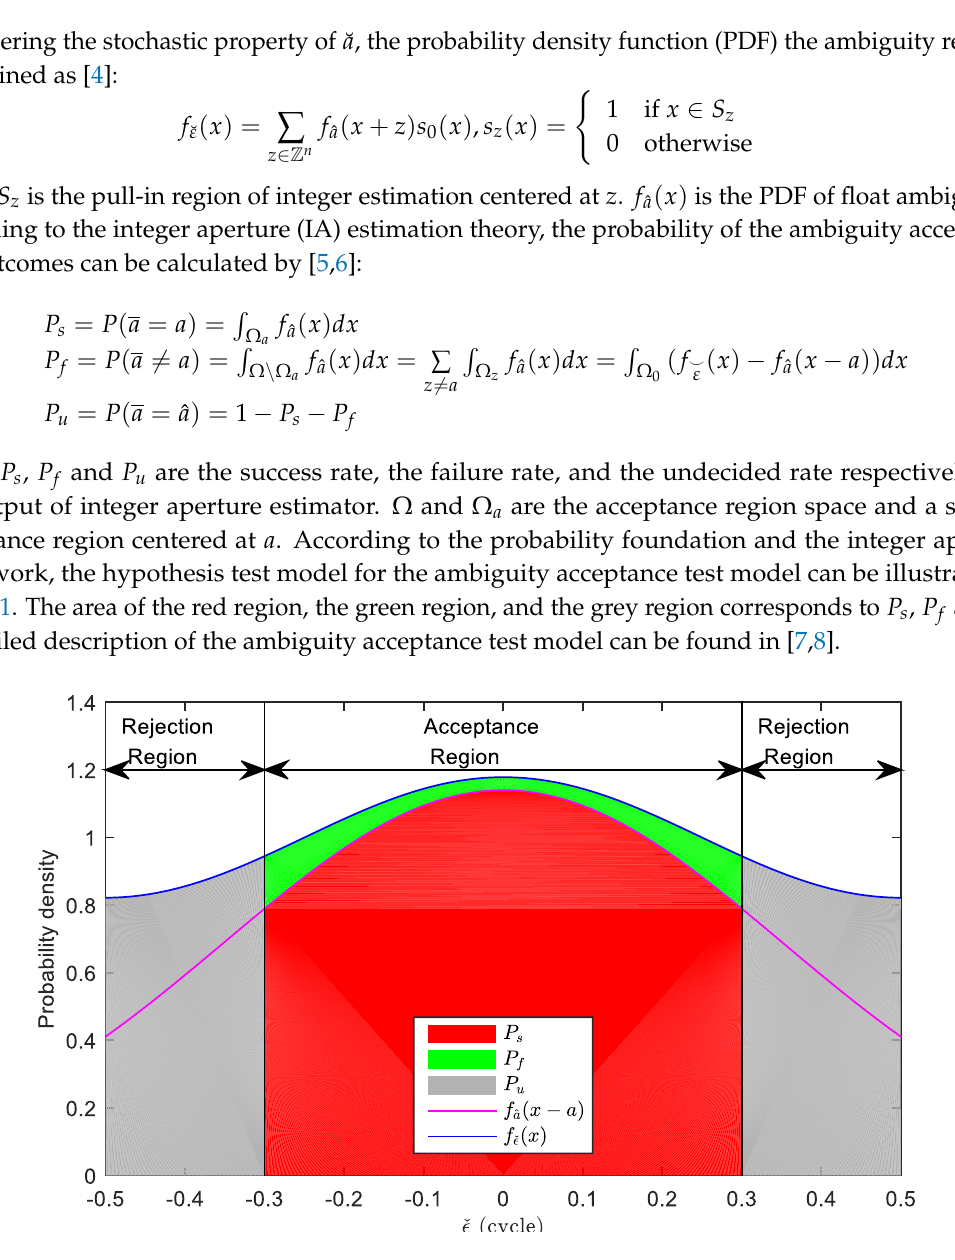
Figure 1. One dimensional example of the ambiguity acceptance test model.